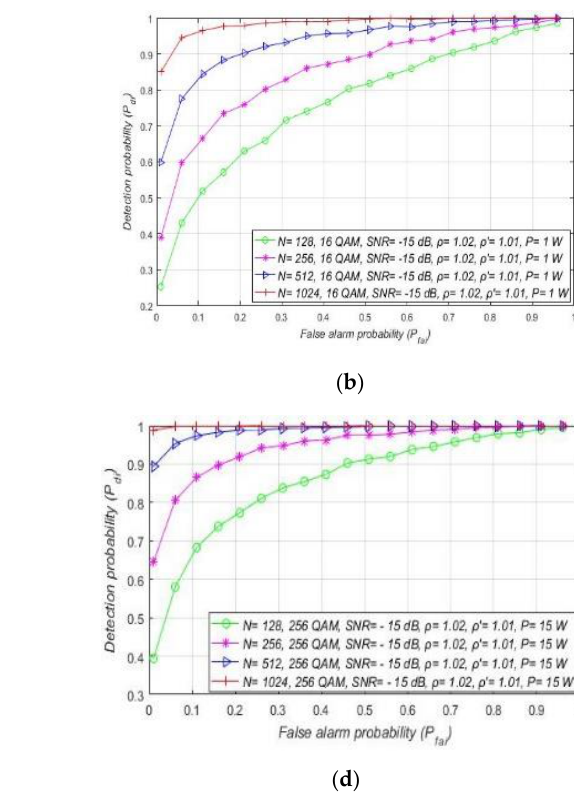
Figure 14. Interdependence between detection and false alarm probabilities for ED of versatile OFDM signals detected with different sample quantities and for PU transmission at Tx power: ( a ) 0.1 W; ( b ) 1 W; ( c ) 10 W and ( d ) 15